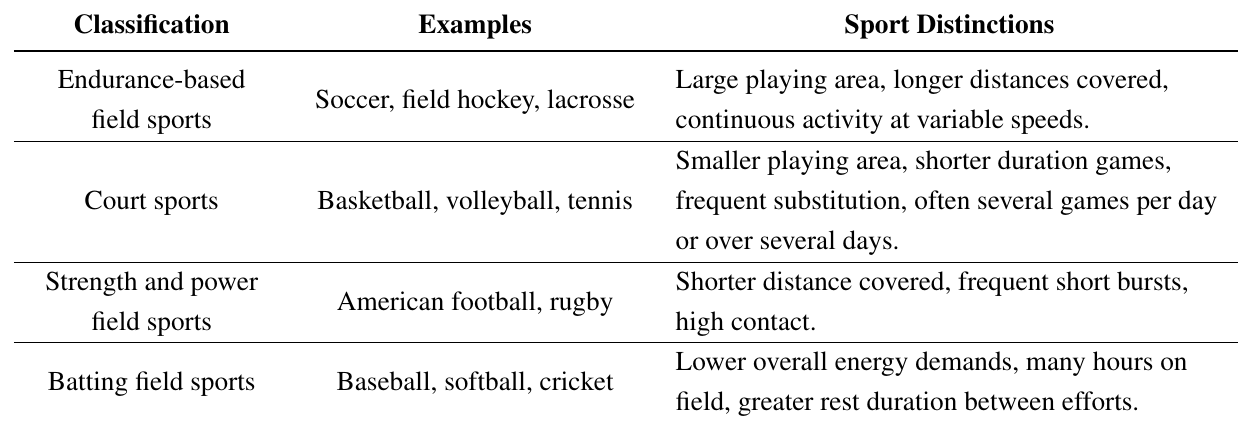
Table information adapted from Holway and Spriet